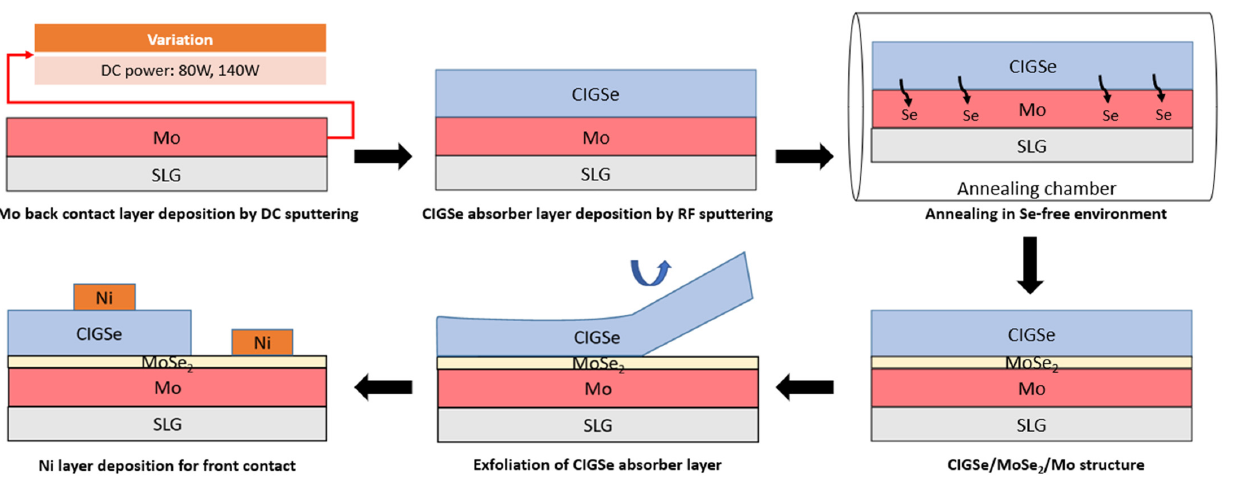
Figure 1. Chronological thin film preparation procedure used in this study.